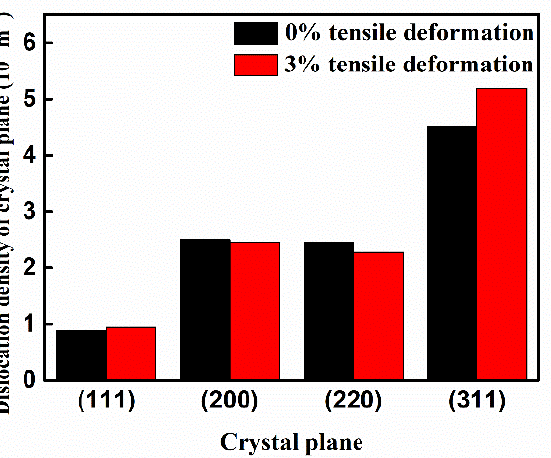
Figure 6. The dislocation density of each crystal plane changes before and after tensile treatment. (The picture has been replaced with a higher